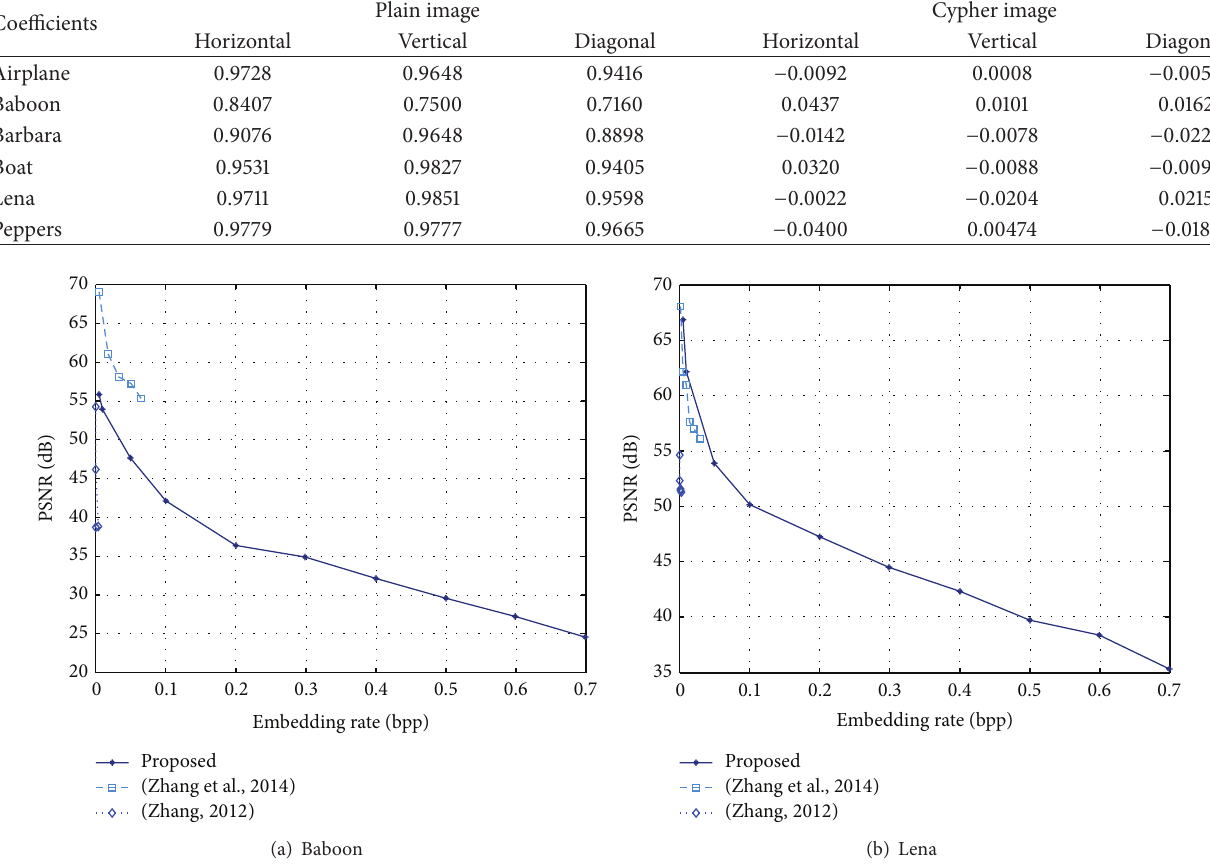
Table 4: Coefficients of different images.